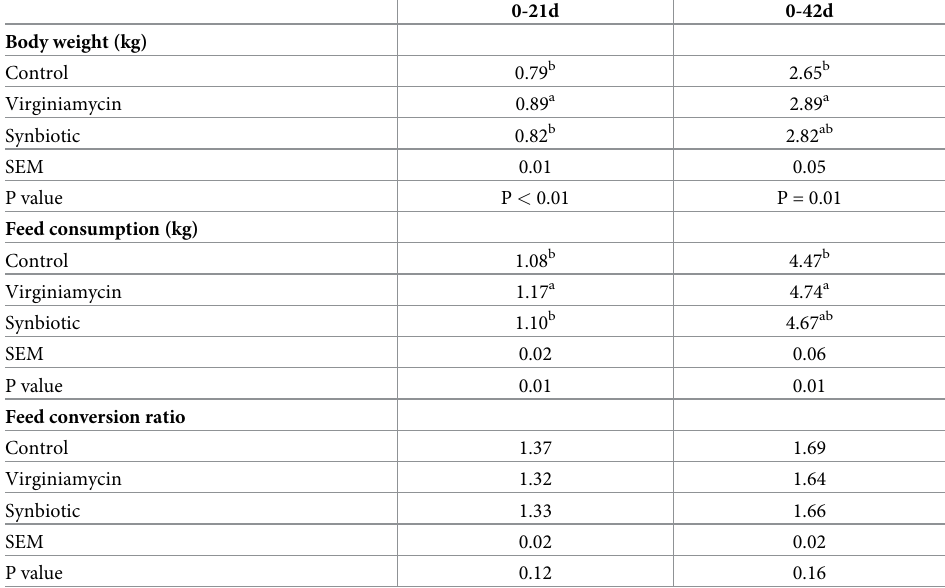
Table 2. Effect of synbiotic supplementation on production parameters post-Salmonella infection in broiler